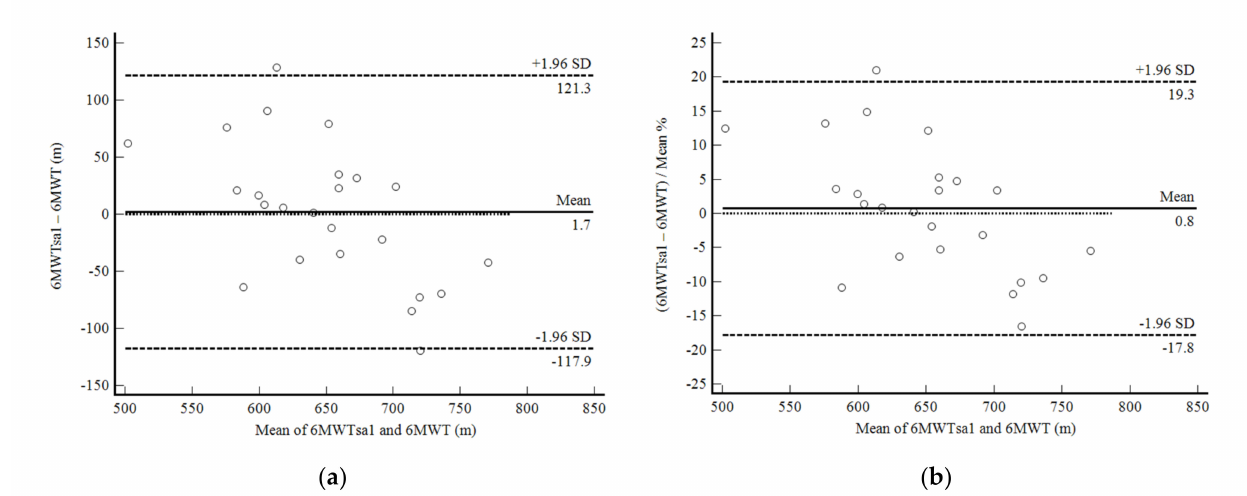
Figure 4. Bland and Altman graphic method with limits of agreement and 95% confidence interval (95%CI) between the distance walked estimated by the number of steps and demographic and anthropometric attributes in the first self-administered six-minute walk test (6MWTsa1) and the supervised six-minute walk test distance (6MWT). ( a ) absolute values; ( b ) percentage